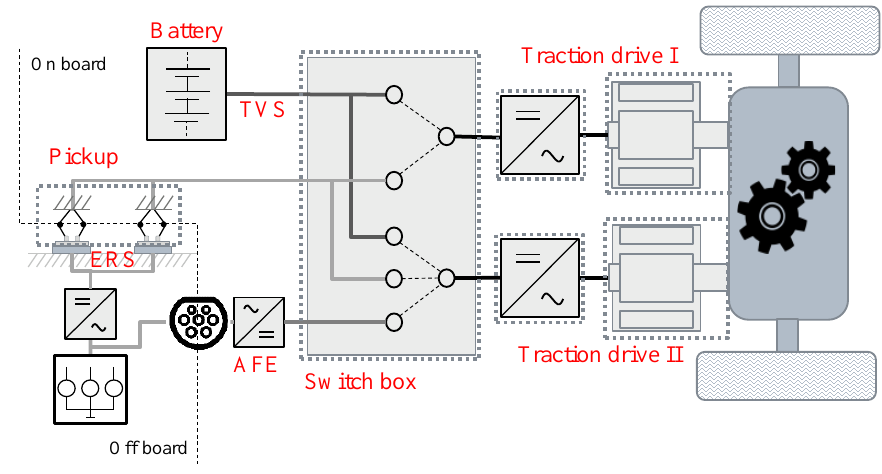
Figure 2. Schematic view of a powertrain with two machines acting as an isolation transformer (FIETS). The thick dashed line indicates where an extra layer of isolation towards the vehicle chassis must be installed.